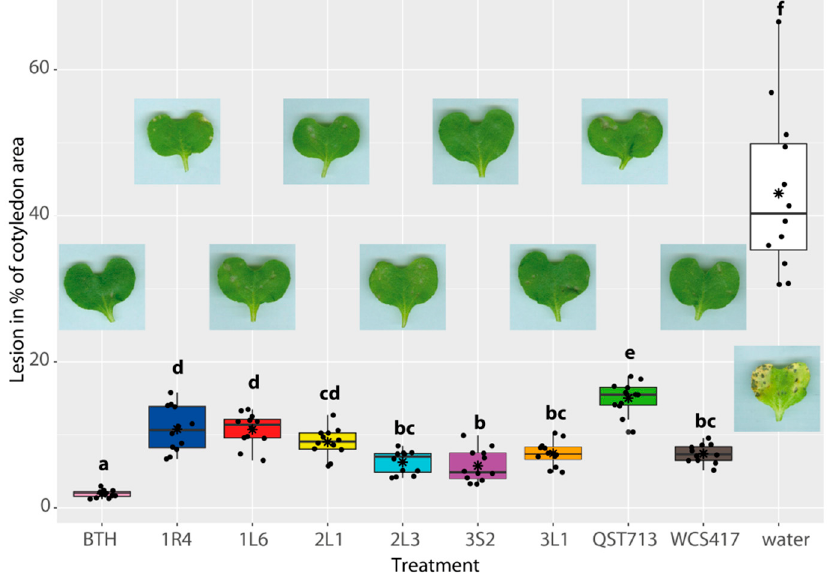
Figure 4. Boxplot of damaged area of rapeseed cotyledons after application of selected endophytic isolates from rapeseed and reference strains of PGP bacteria followed by infiltration by Leptosphaeria maculans . Boxes indicate 1st and 3rd quartiles, horizontal line is median, asterisk is average, whiskers indicate 1.5 times theinterquartile range, and dots are data points. Boxes accompanied with the same letter are not significantly different at α = 0.05 according to Fisher LSD test.